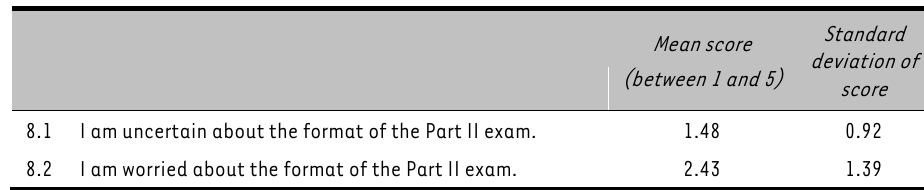
Perceptions about QE 2